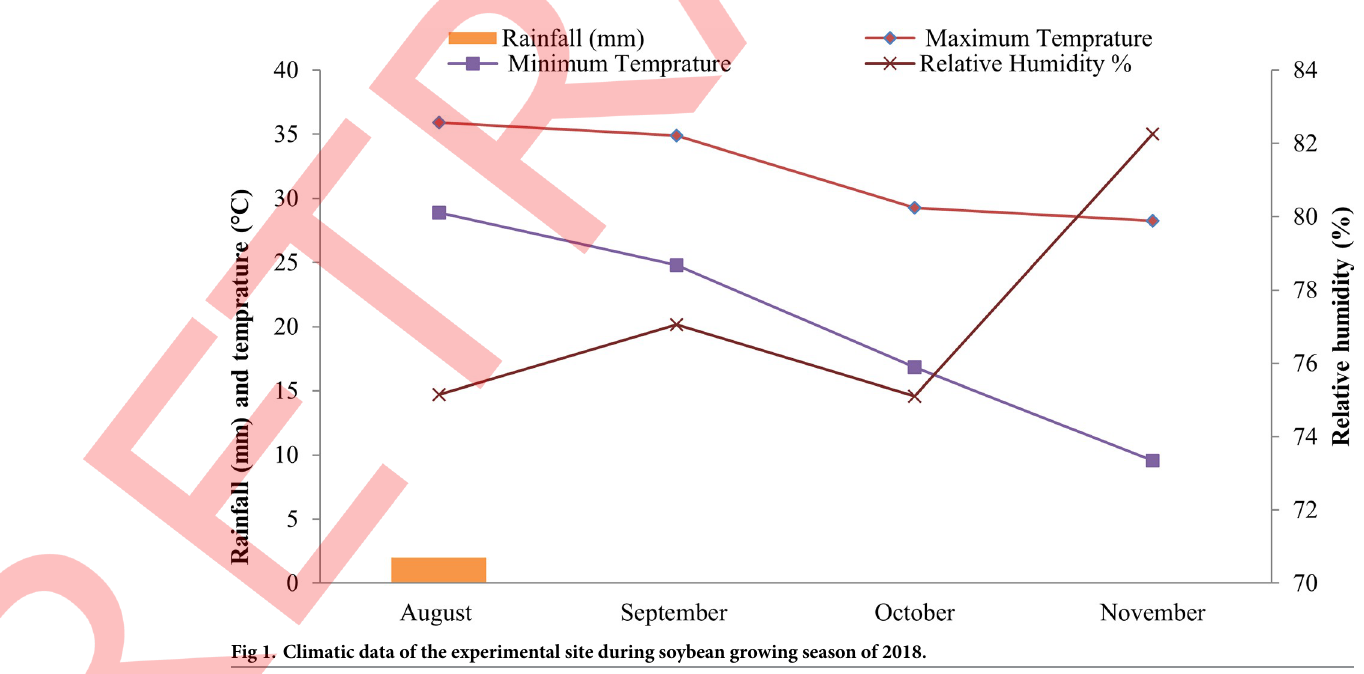
Fig 1. Climatic data of the experimental site during soybean growing season of 2018.